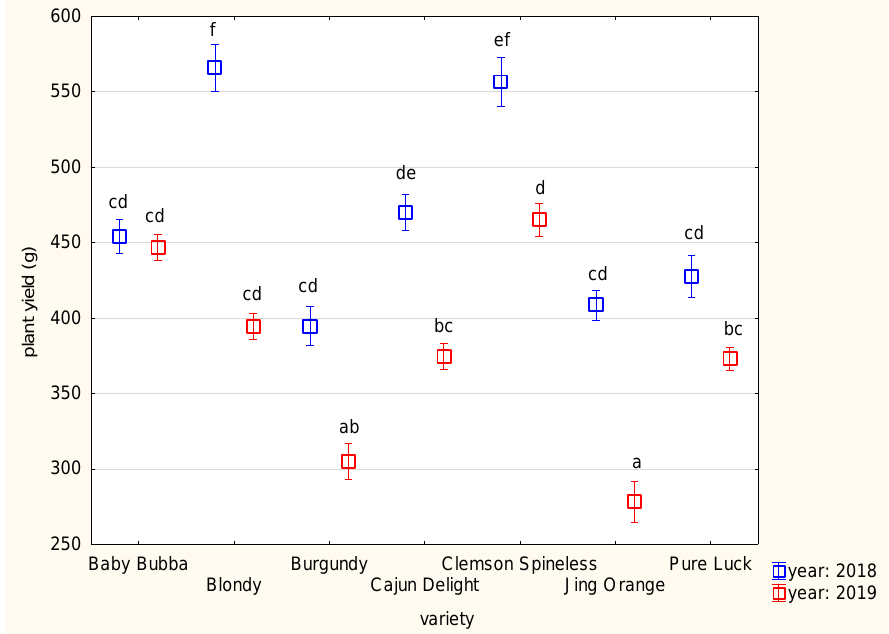
Figure 2. Yield of okra fruits per plant by Scheffe test (error bars represent SD; different letters among cultivars and years show statistically significant differences at the level p < 0.05).